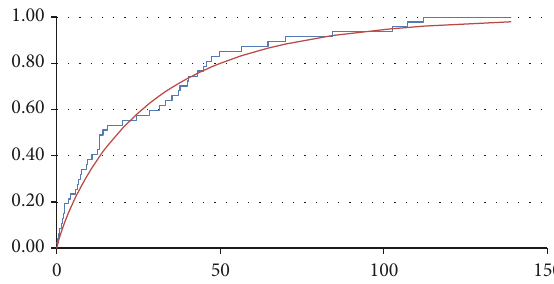
Figure 1: The empirical CDF 𝐹 𝑛 (𝑥) (blue color) and the Weilbull CDF 𝐹 0 (𝑥) (red color).